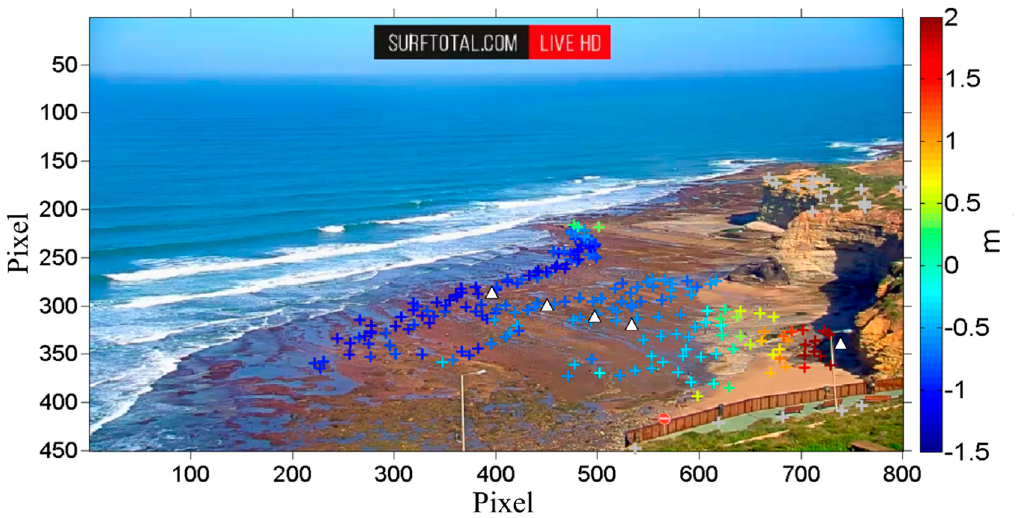
Figure 3. Terrain points location and related elevation (crosses), pressure transducers deployment position (PTs, white triangles) plotted on surfcam frame acquired during low tide. Note that colorbar elevation is comprised between − 1.5 and 2 m for clarity. Surveyed points on the cliff (gray crosses) are about 25 m high.